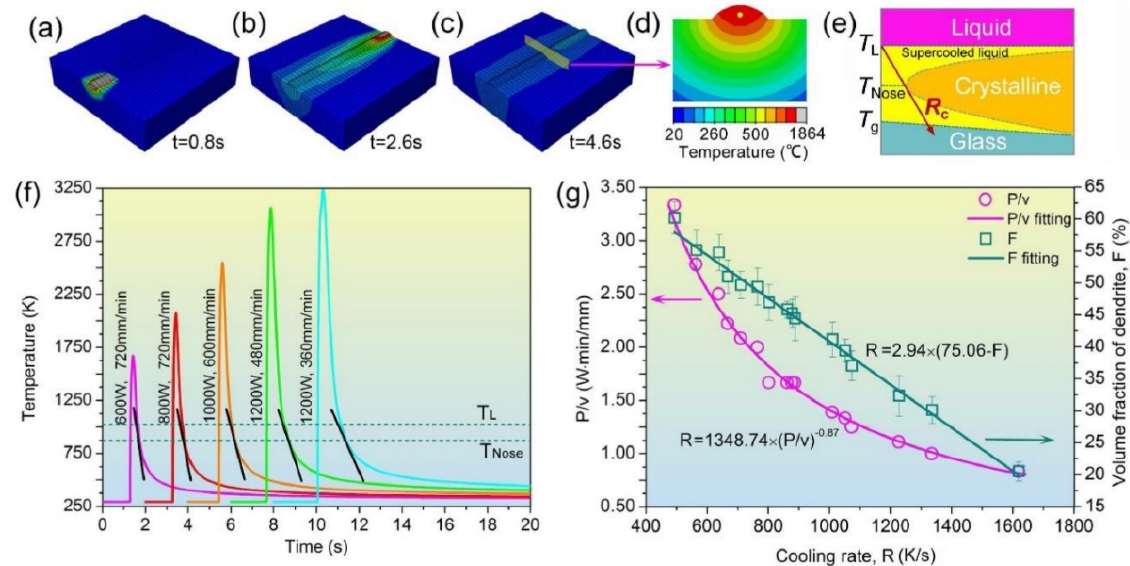
Figure 37. ( a – c ) FEM simulation of a single laser track, ( d ) illustration of the temperature field of the cross-section of the simulated track, ( e ) schematic of a TTT diagram, ( f ) thermal histories of tracks with different parameters used in the fabrication of the BMGC, and ( g ) relationship between the computed cooling rate, processing parameters, and the measured volume fraction of crystallization. Reproduced from [102], with permission from Elsevier, 2021.